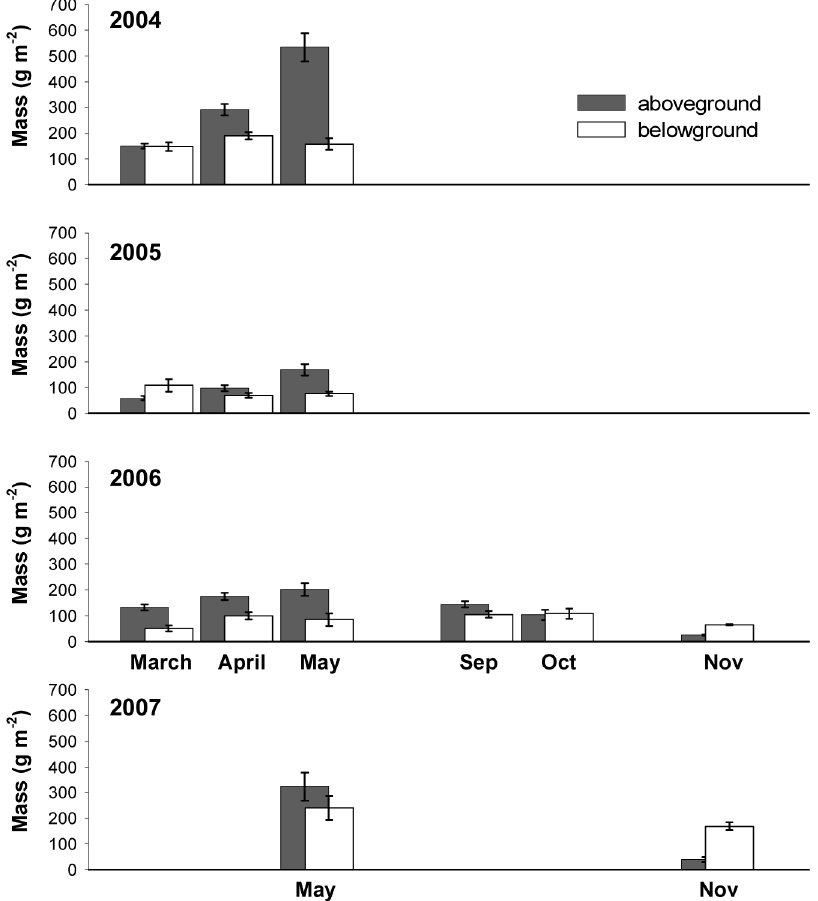
Fig. 1. Aboveground and belowground mass (g m –2 ) measured in gaps of the low Macchia at Castel Volturno nature reserve during the study years. Values are means of 18 measurements at each